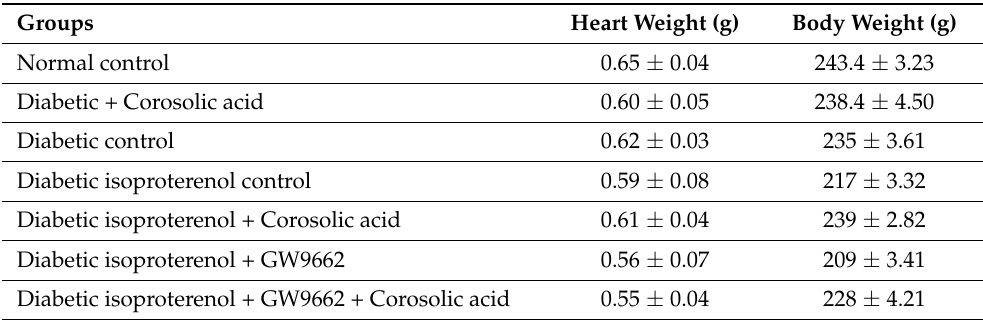
Figure 1. The effect of corosolic acid on the ratio between animal heart weight and body weight. The data are expressed as mean ± SEM ( n = 6). Table 1. Effect of corosolic acid on weights in different experimental